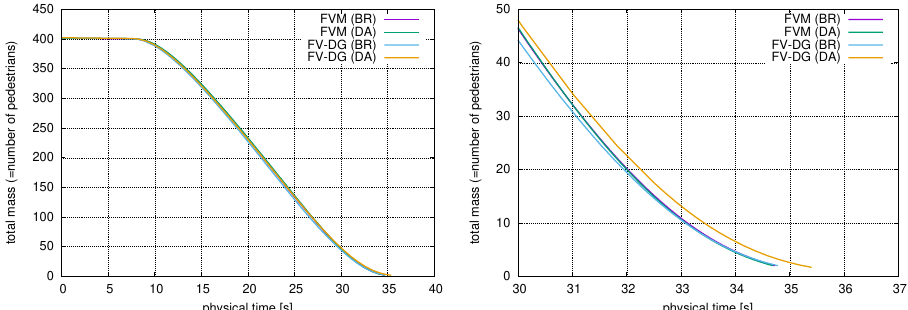
Figure 2. Domain with one obstacle, FV(BR), FV(DA) ( top ) and FV-DG(BR), FV-DG(DA) ( bottom ). Density distribution at time t = 10,15,20 s obtained on the finest meshes.